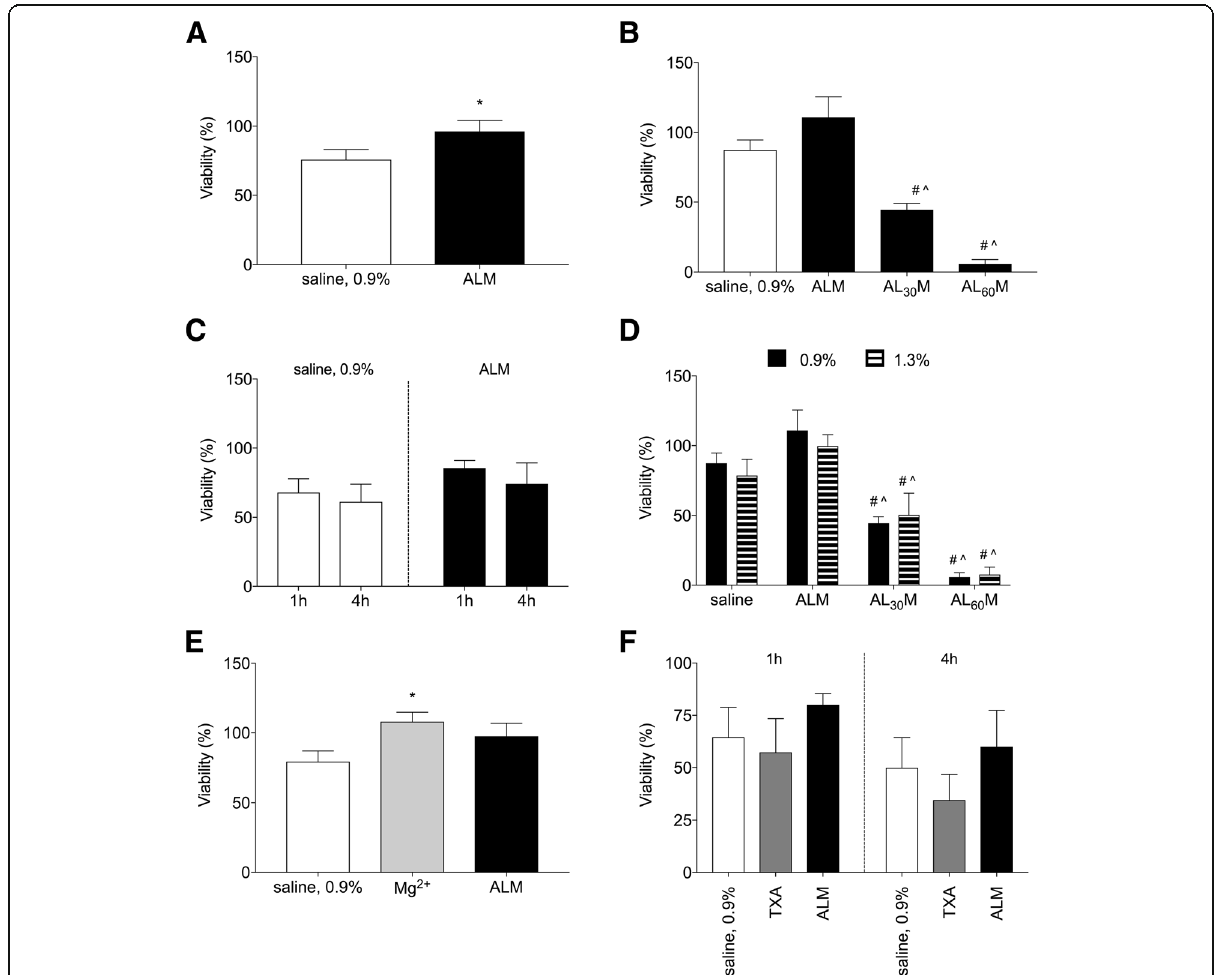
Fig. 2 Effect of saline, ALM and TXA solutions on chondro-MSC viability, where cell viability is defined as the mean absorbance of treated (saline, ALM, TXA) cells normalised to the mean absorbance of untreated (culture media only) cells. a Compared to 0.9% saline, viability was significantly greater in cultures exposed to ALM solution for 1h ( P =.045, n =13). b Increasing lidocaine concentrations within the ALM preparation to 30mM (AL 30 M) and 60mM (AL 60 M) resulted in significantly reduced viability ( P <.001, n =6, # compared to saline; ^ compared to ALM). c There were no significant differences in chondrocyte viability at 1 and 4h exposure of chondrocytes to ALM solution. d No significant differences were observed between 0.9% and 1.3% saline (n=6). e Compared to normal saline (0.9%), addition of Mg 2+ significantly improved cell viability ( P =.043, n =11). f No significant differences were observed in the viability of cultures exposed to ALM solution or TXA for 1 ( P =.47) or 4h ( P =.49; n =5). Data is expressed as mean± S.E.M. ALM, adenosine, lidocaine, and magnesium; MgSO 4 , magnesium sulphate; MSC, mesenchymal stem cells; TXA, tranexamic